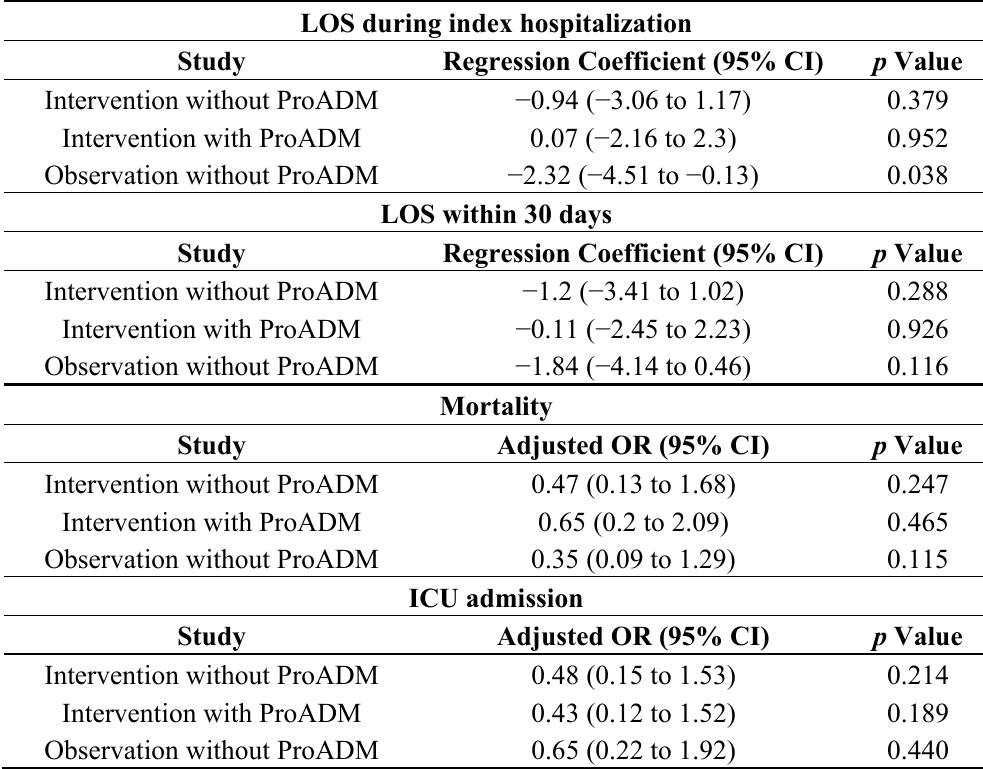
Table 2. Efficacy and safety outcome in the observation with ProADM (OPTIMA III) compared to former studies. All analyses are adjusted for age, sex, CURB65, albumin, and procalcitonin.